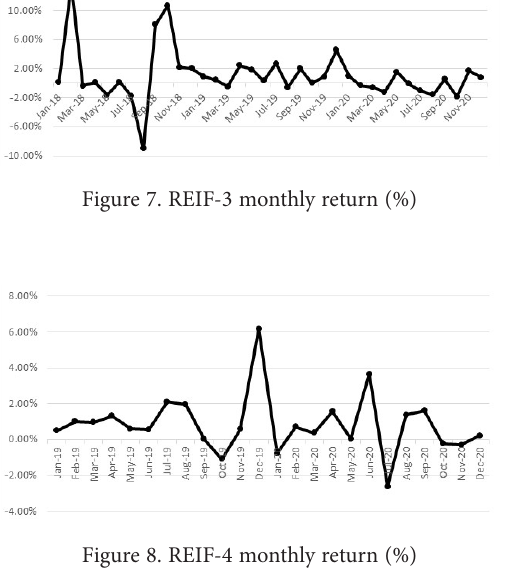
Figure 8. REIF-4 monthly return (%)